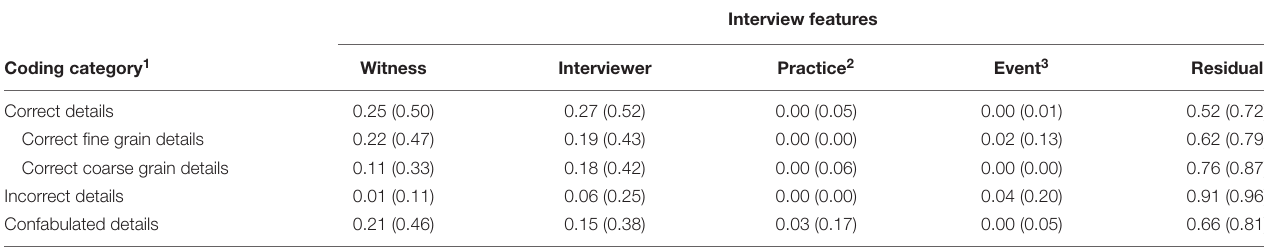
FIGURE 1 | Proportional representation of the variance explained in the linear mixed model presented in Table 3 . TABLE 4 | The standardized estimates (SD) of witness, interviewer, practice, witnessed event, and residual variance influence on the interview